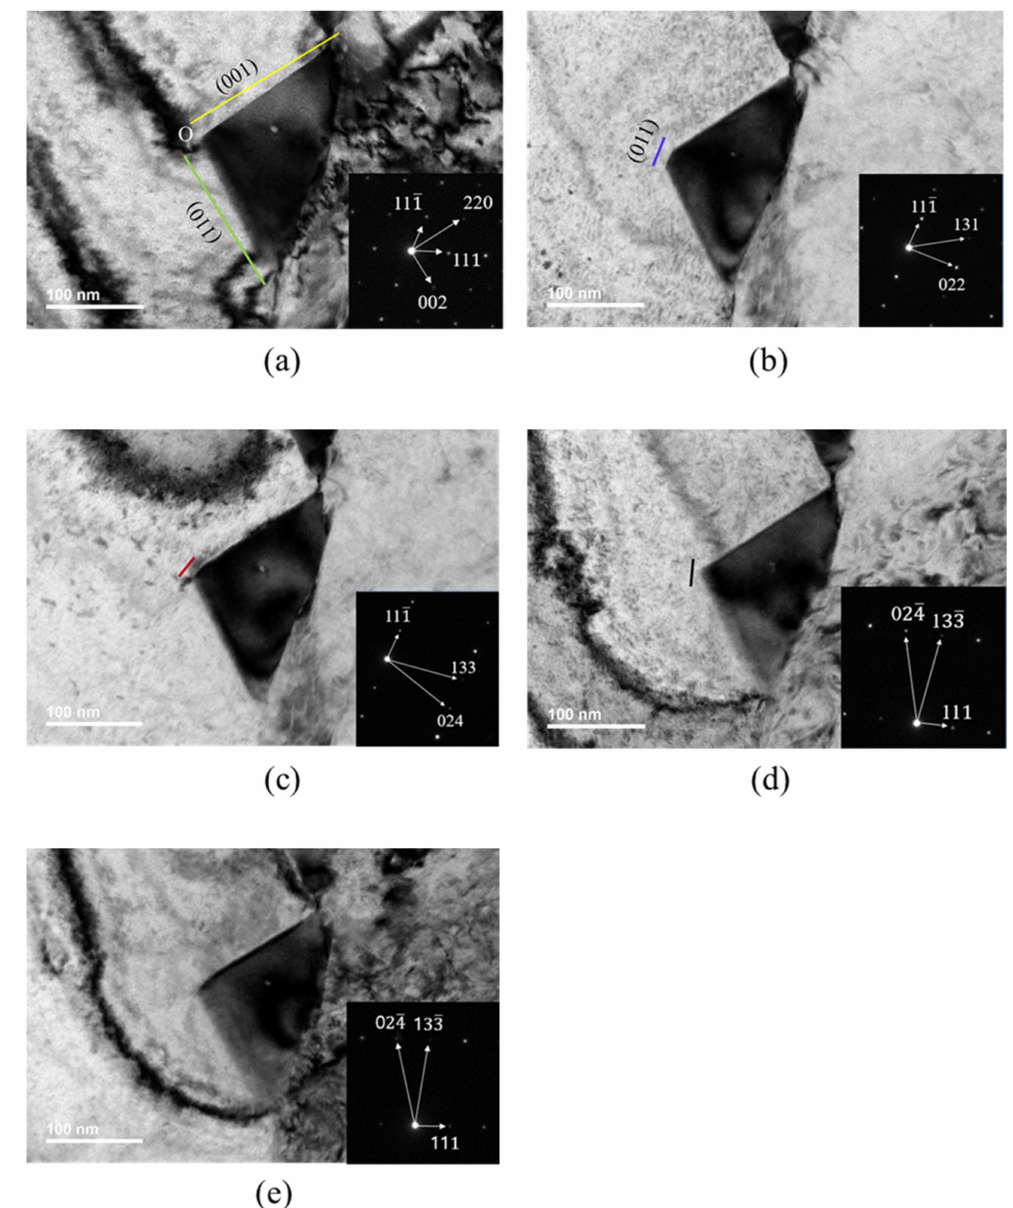
Figure 4. TEM image and SAED of carbide with beam directions: ( a ) [110]; ( b ) [211]; ( c ) [321]; ( d ) [231]; ( e )